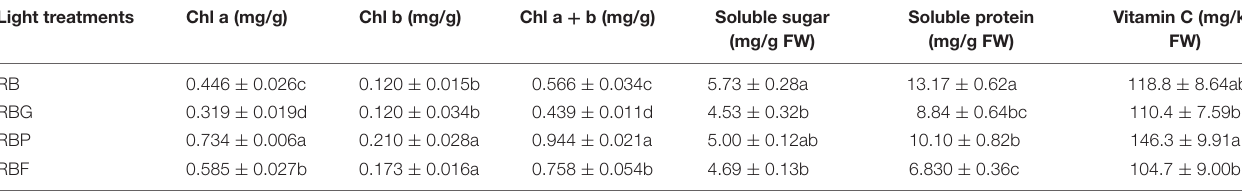
TABLE 1 | Effects of spectra on the quality of lettuce under different LED treatments. Light